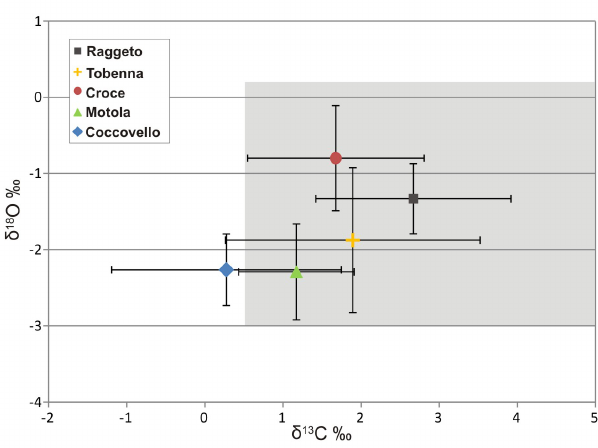
Fig. 14. Plot of the mean ± standard deviation of carbon and oxy- gen isotope ratios for each studied section. With the exception of Mt. Coccovello, the δ 13 C and δ 18 O mean values of the studied sections fall within the range of Barremian-Aptian seawater, rep- resented by the “low-latitude” biotic calcite record of Prokoph et al. (2008).